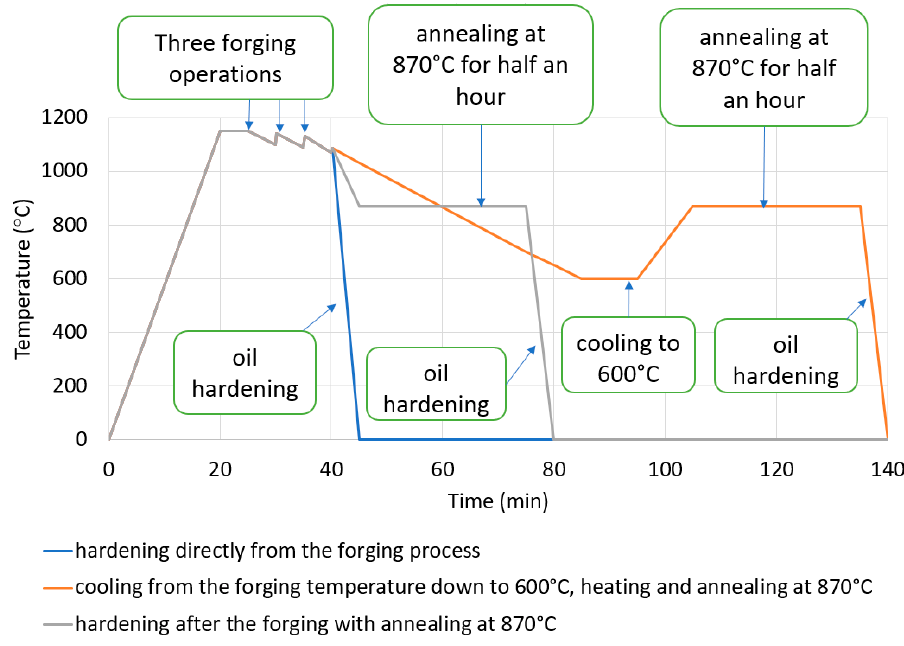
Figure 4. The paths scheme of the proposed thermal treatment variants directly after the forging process.